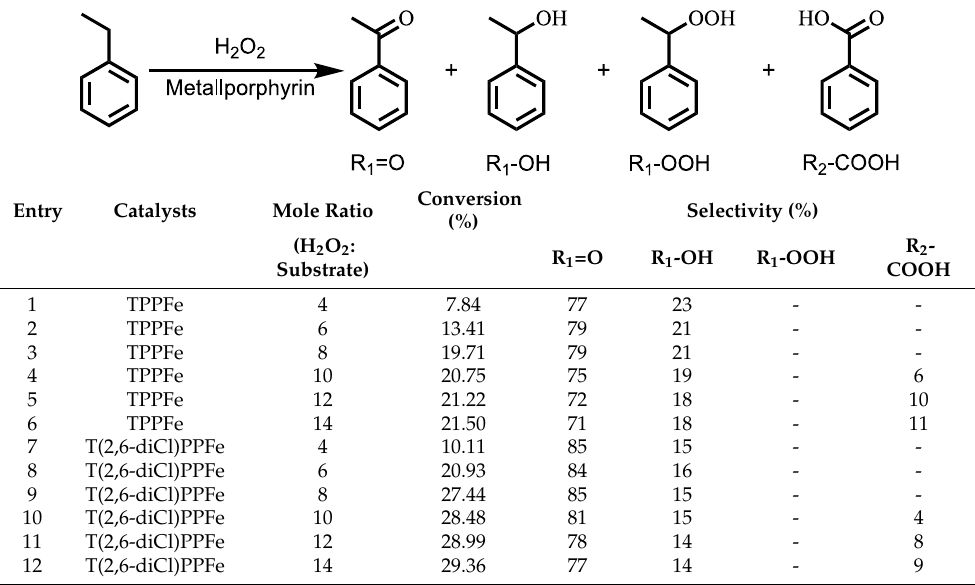
Table 5. Effect of oxidant amount on alkyl aromatics oxygenation employing ethylbenzene as model substrate a .